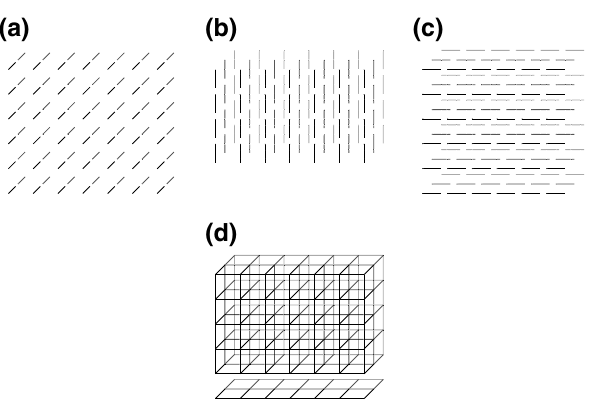
FIG. 6. Graphical representation of the cubic lattice associated to a 3D product code where the seed matrices δ A , δ B , δ C have size 2 × 3, 4 × 6, and 6 × 7, respectively. In (a), (b), and (c) only transversal, vertical, and horizontal edges are depicted. In (d) we can see the complete lattice obtained by matching the origin O = ( 1, 1, 1 ) of the three lattices of